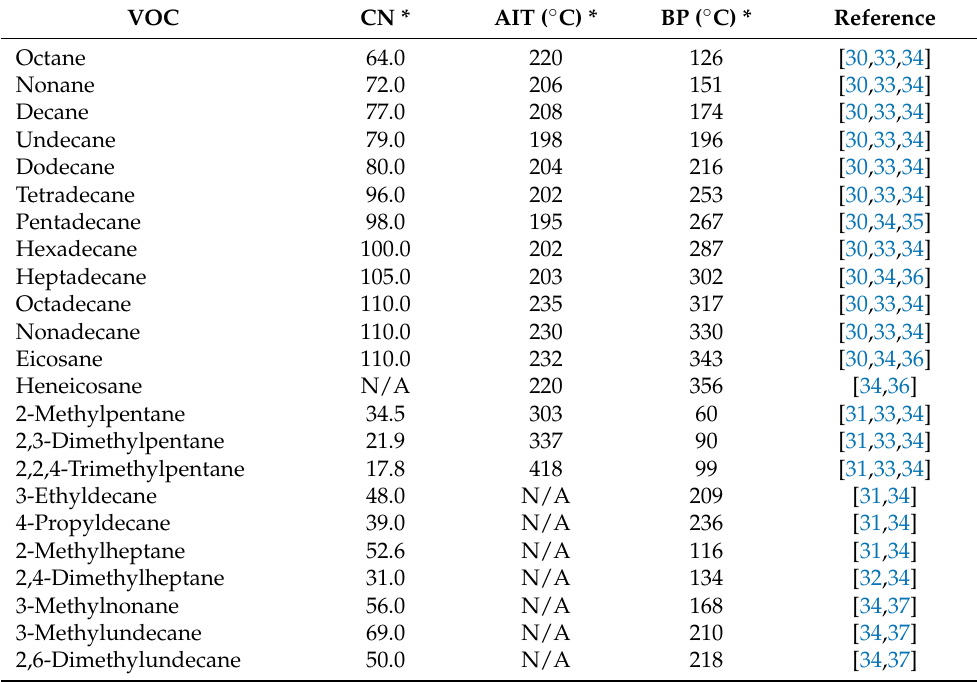
Table 2. Cetane number (CN), autoignition temperature (AIT), and boiling point (BP) values of some VOCs detected and discussed in the current